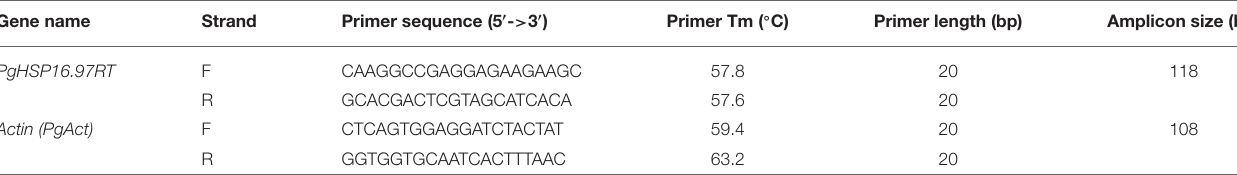
TABLE 3 | Details of gene-specific primers for qRT-PCR gene expression